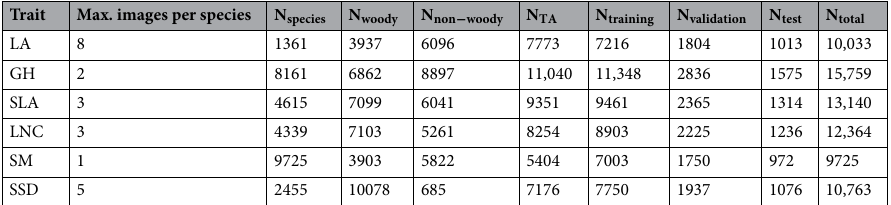
Table 1. Summary of plant functional trait datasets. Information on the maximum number of images per species, total number of species ( N species ), number of images with woody ( N woody ) and non-woody species ( N non − woody ), number of observations with non-zero standard deviations for Plasticity setup ( N TA ), number of images in training ( N training ), validation ( N validation ) and test ( N test ) dataset as well as total number of images ( N total ) in each trait dataset. LA, leaf area; GH, growth height; SLA, specific leaf area; LNC, leaf nitrogen concentration; SM, seed mass; SSD, stem specific density.